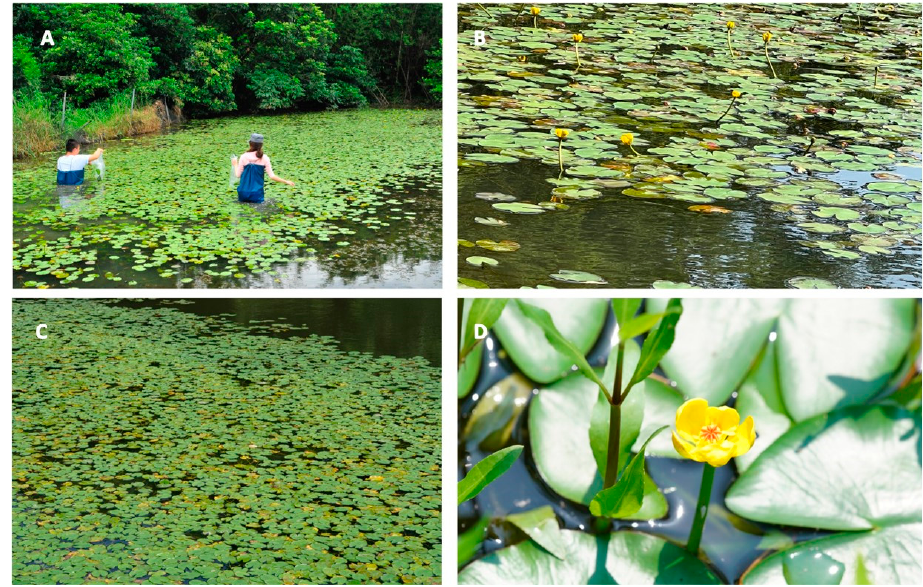
Figure 1. The four N. shimadai populations in freshwater ponds found in different areas of Taoyuan City, northern Taiwan: ( A ) WP, ( B ) GPa, ( C ) GPb and ( D ) GPn. City, northern Taiwan: ( A ) WP, ( B ) GPa, ( C ) GPb and ( D )